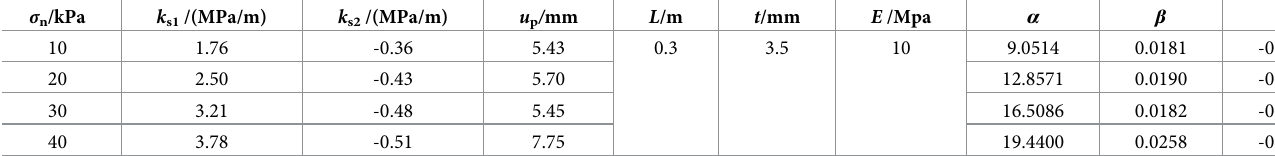
Table 4. Simulated parameters of the pull-out tests.